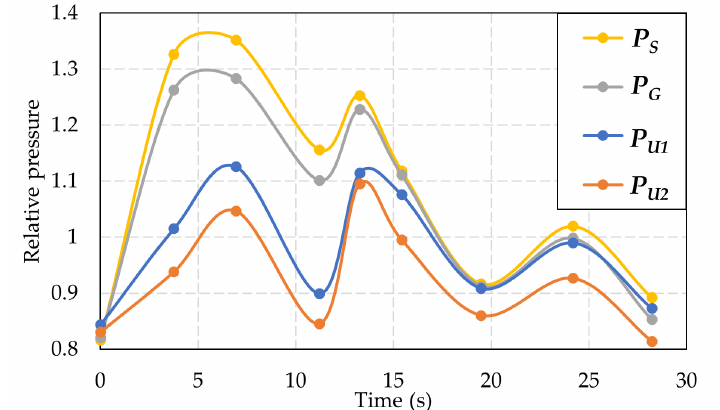
Figure 7. Pressure change at the monitoring